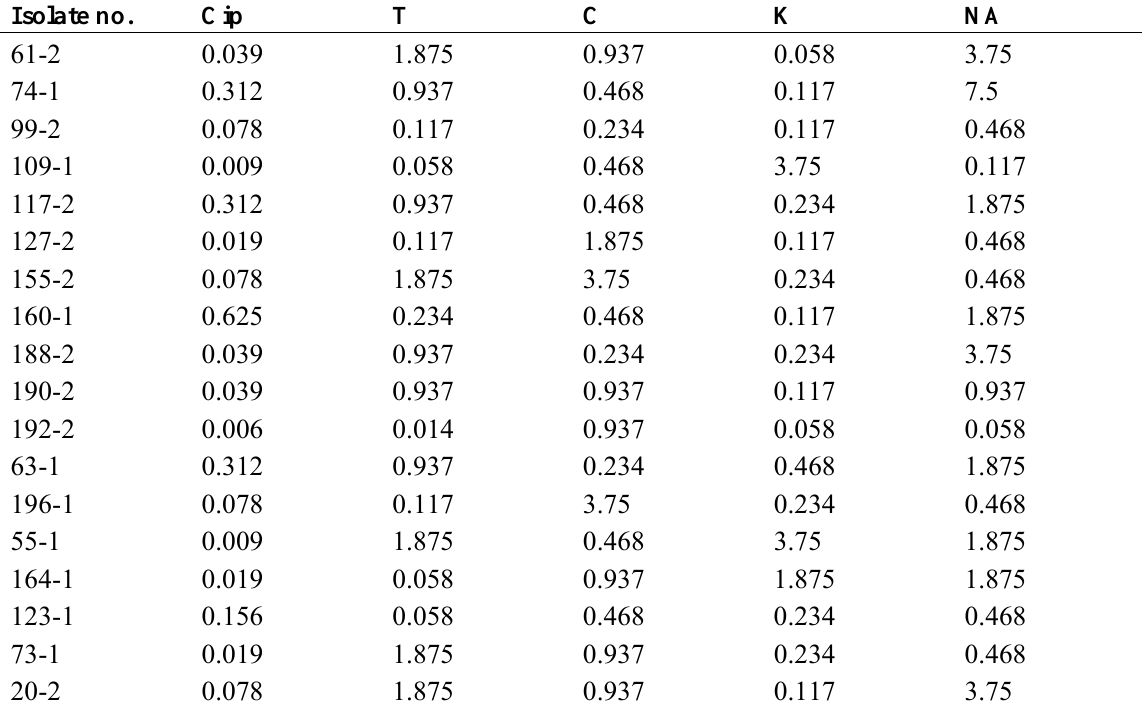
Table 4. Minimum inhibitory concentration (MIC L. ivanovii